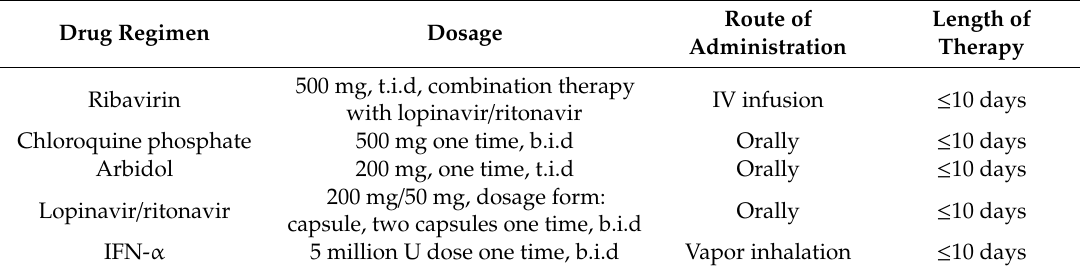
Table 4. Antivirals included in the treatment guidelines issued by NHC of China for COVID-19, version 6 [107,109]. NHC, National Health Commission; t.i.d, three times a day; b.i.d, two times a day. Route of Length of Drug Regimen Dosage Administration Therapy 500 mg, t.i.d, combination therapy Ribavirin IV infusion ≤ 10 days with lopinavir / ritonavir Chloroquine phosphate 500 mg one time, b.i.d Orally ≤ 10 days Arbidol 200 mg, one time, t.i.d Orally ≤ 10 days 200 mg / 50 mg, dosage form: Lopinavir / ritonavir Orally ≤ 10 days capsule, two capsules one time, b.i.d IFN- α 5 million U dose one time, b.i.d Vapor inhalation ≤ 10 days Hydroxychloroquine, lopinavir / ritonavir, chloroquine, and darunavir / cobicistat are being